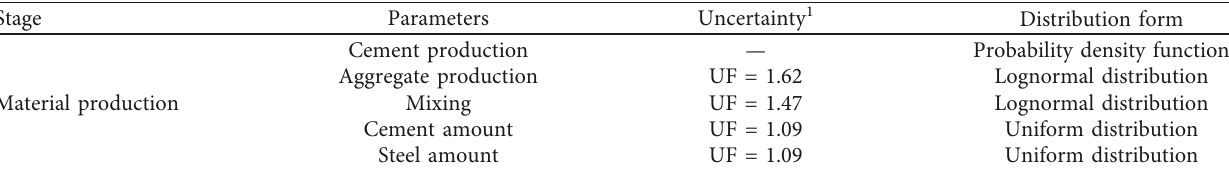
Table 7: Parameter uncertainties of the cement pavement LCA model.